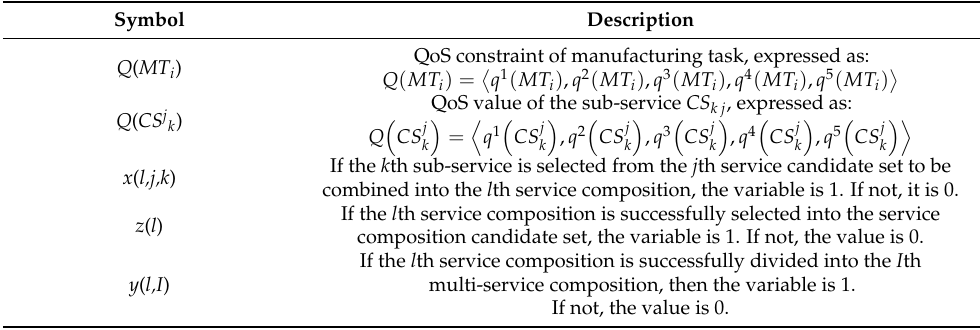
Table 6. Parameters and decision